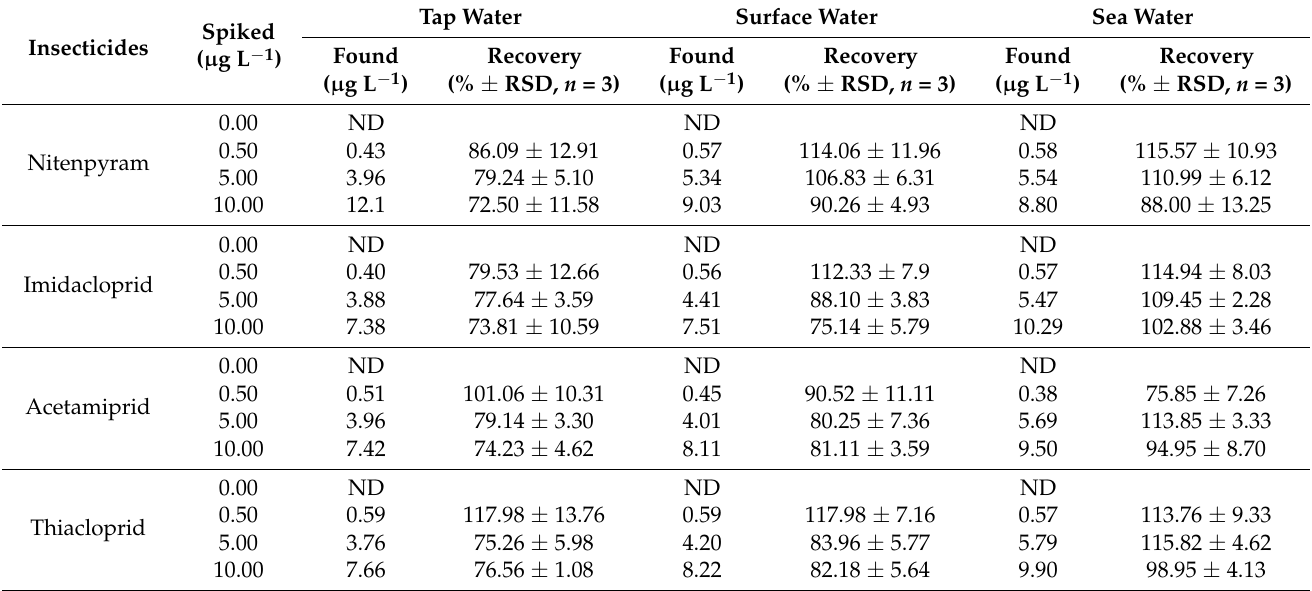
Table 4. Method performance comparison for neonicotinoid insecticides by HPLC in water sam- ples.